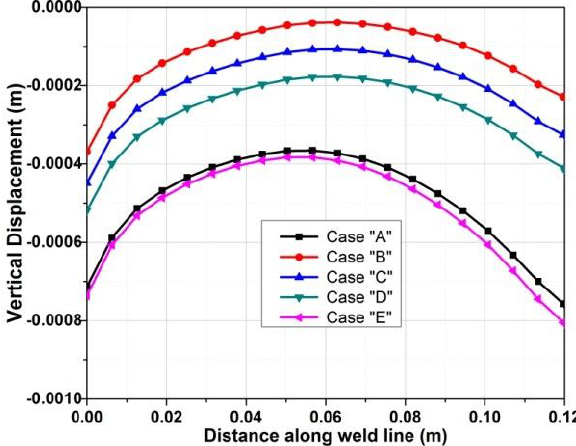
Figure 10: Simulated Vertical Displacement along weld